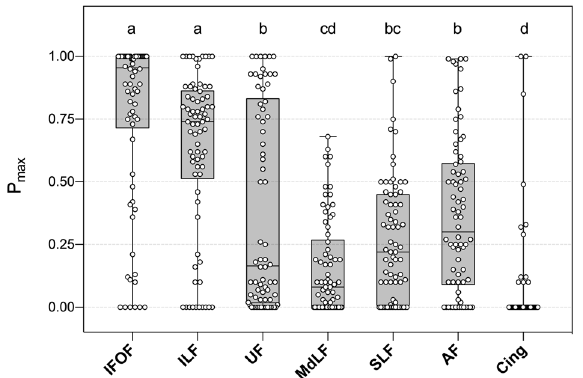
Figure 2. Box plots reporting the values of p max within the main white matter tracts in 74 electrostimulations. AF arcuate fasciculus, Cing cingulum, ILF inferior longitudinal fasciculus, IFOF inferior fronto-occipital tract, MdLF middle longitudinal fasciculus, SLF superior longitudinal fasciculus, UF Uncinate fasciculus. p max is the maximal probability of disconnection for a given white matter tract. Data are presented as median, quartiles and extreme values. Different letters indicate statistical significance with an adjusted P-value <